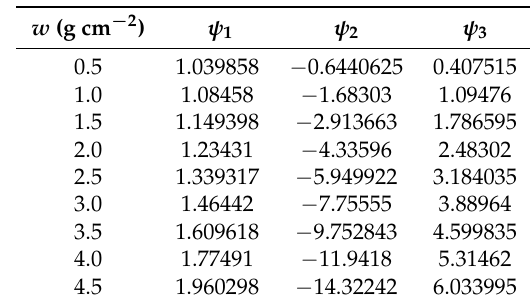
Table 2. Atmospheric functions calculated for different amount of water vapor contents following Equations